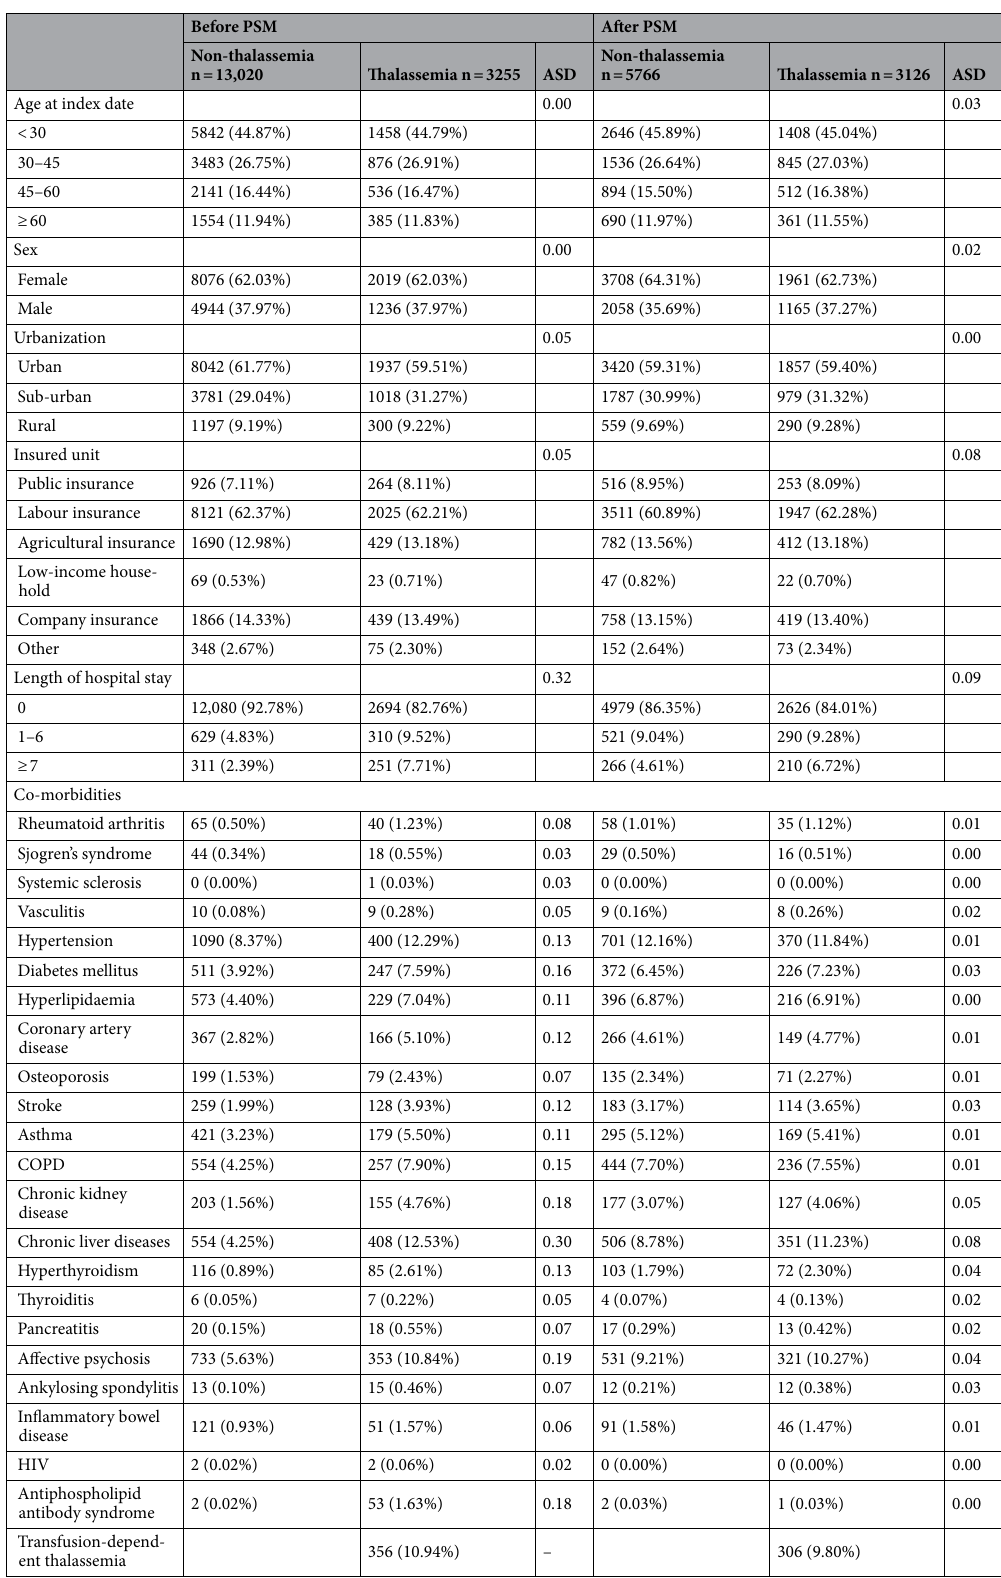
Table 1. Characteristics among thalassemia groups and non-thalassemia